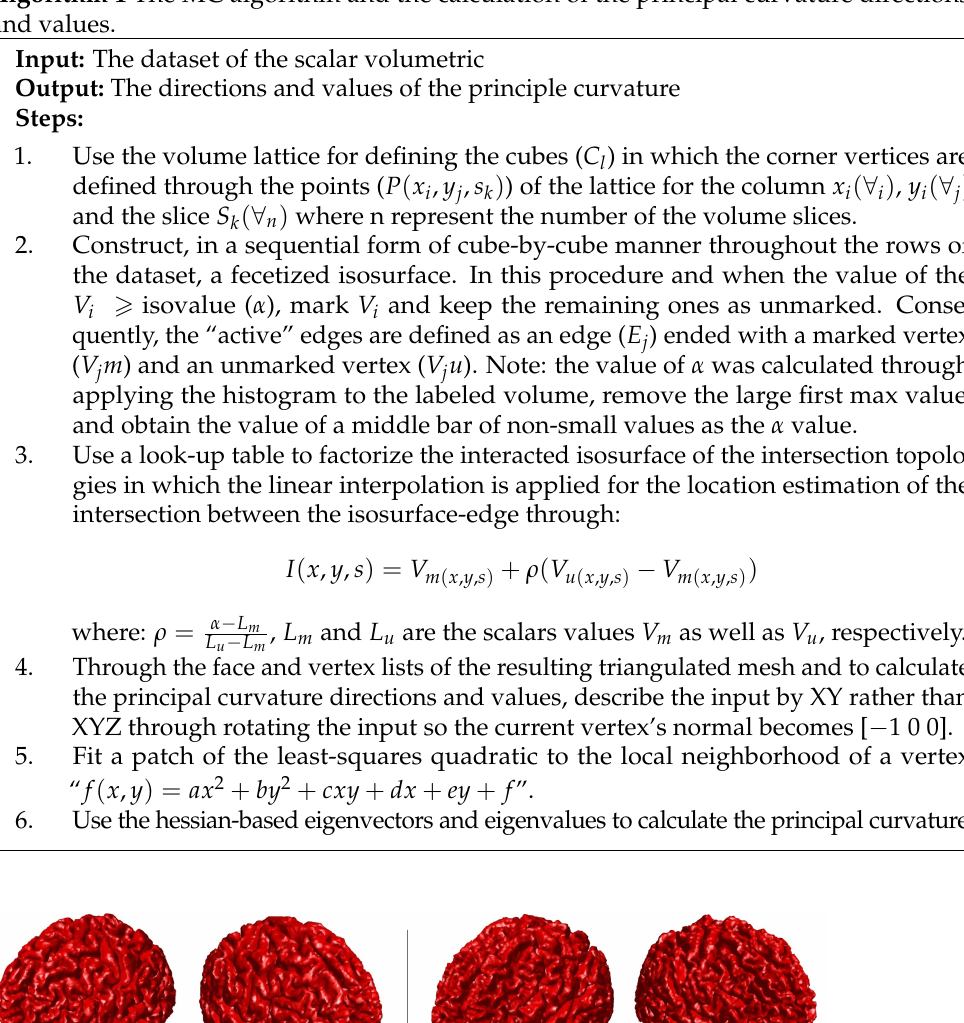
Algorithm 1 The MC algorithm and the calculation of the principal curvature directions and values.